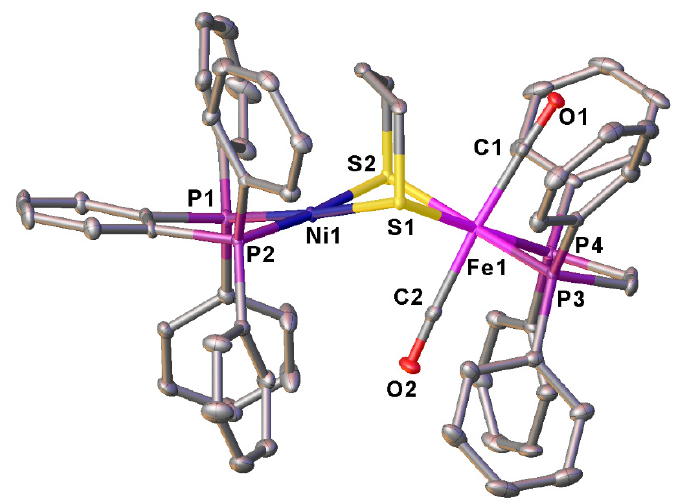
Figure 2. Molecular structure of [ A ](BF 4 ) 2 with thermal ellipsoids drawn at a 30% probability level. All H atoms and two BF 4 − anions are omitted for the sake of clarity. Selected bond lengths (Å) and angles ( ° ): Ni ⋅⋅⋅⋅ Fe 3.1875, Ni1-S1 2.2301(11), Ni1-S2 2.2314(12), Fe1-S1 2.3106(11), Fe1-S2 2.3235(11), Fe1-P3 2.2330(12), Fe1-P4 2.2426(12), Ni1-P1 2.1585(12), Ni1-P2 2.1647(12); S1-Ni1-S2 84.03(4), P1- Ni1-S1 175.93(5), P1-Ni1-P2 87.54(4), S1-Fe1-S2 80.24(4), P3-Fe1-S1 92.74(4), P3-Fe1-P4 87.34(4).